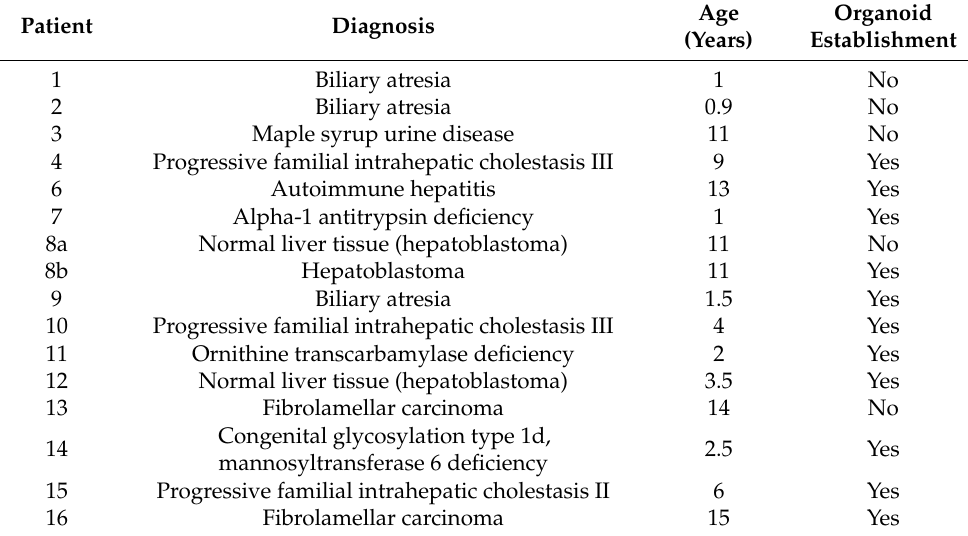
Table 1. Patient characteristics and organoid